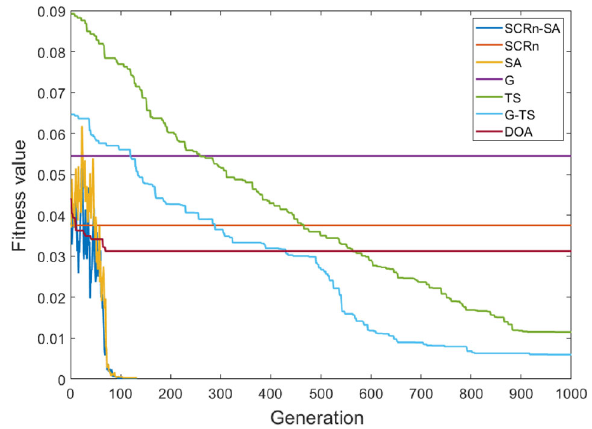
Fig. 10 Convergence curve for F 8